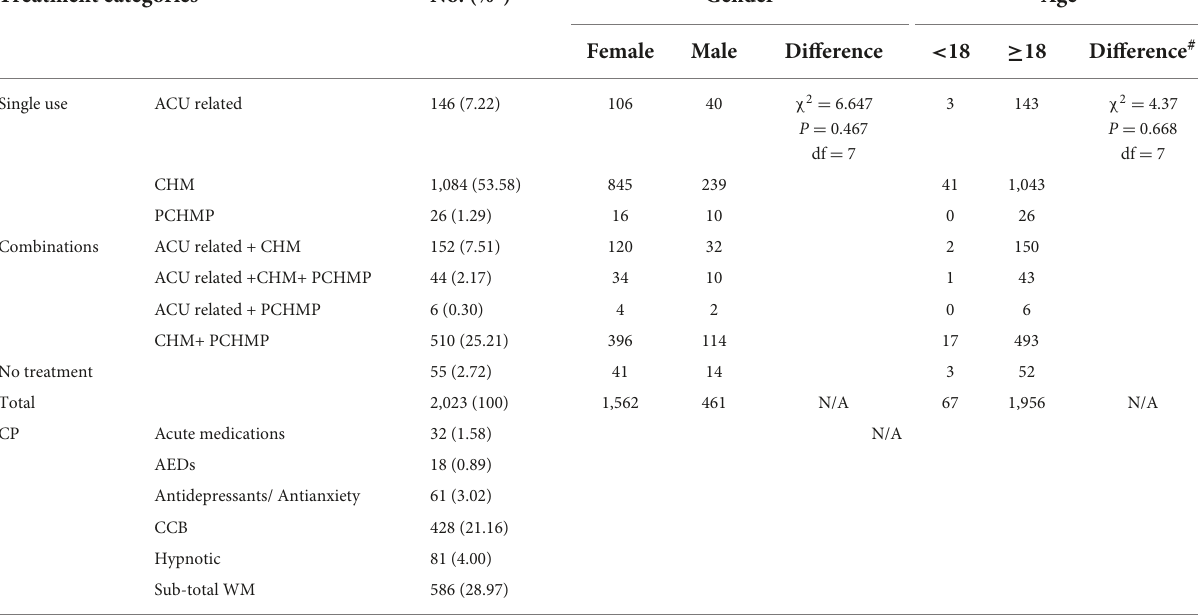
TABLE 2 Treatment